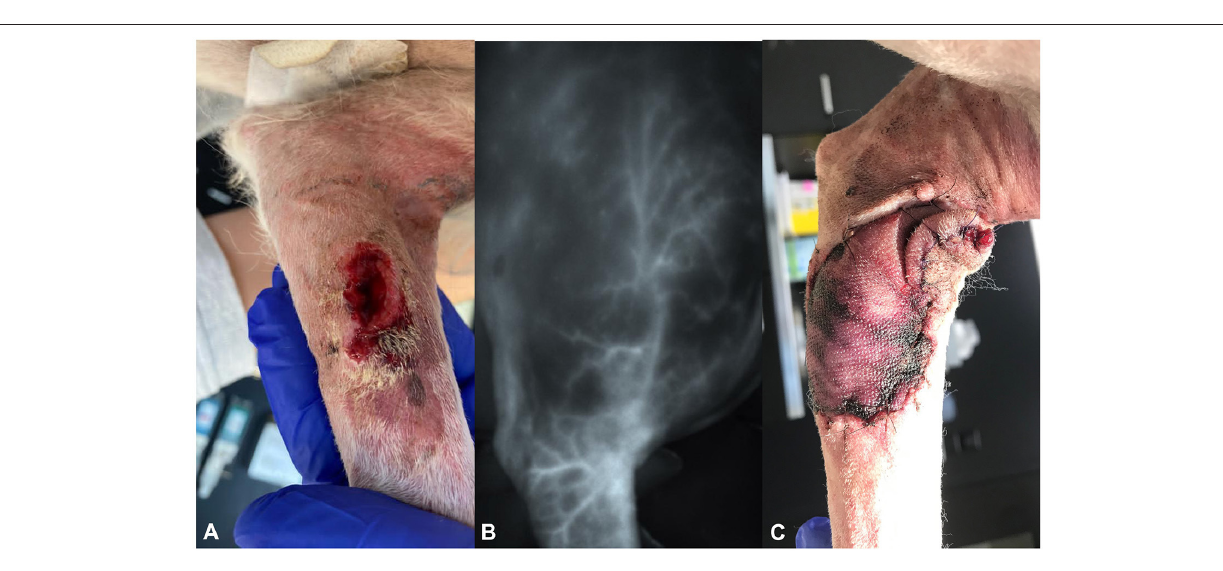
FIGURE 2 | Photographs of dog 2, showing (A) the dehiscent wound on the left medio-proximal antebrachium at presentation, (B) the delineation of the superficial brachial artery using the VisionSense VS3-IR-MMS camera system intraoperatively, and (C) the discoloration of the distal edges of the flap on day 6